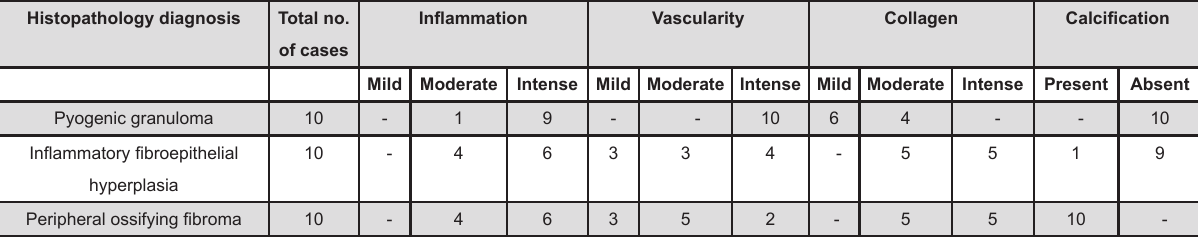
Figure 1- Histopathological findings of pyogenic granuloma, inflammatory fibroepithelial hyperplasia, and peripheral ossifying fibroma